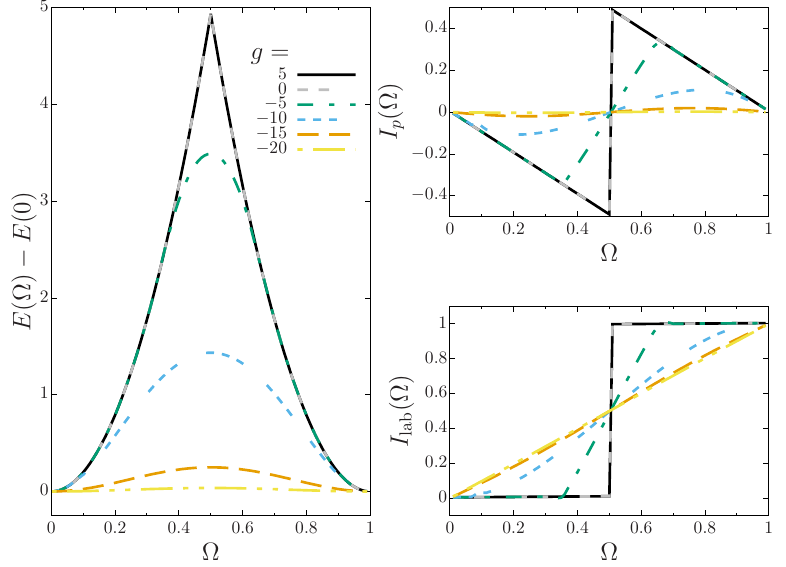
Figure 9: Mean-field simulations of the Gross-Pitaevskii equation, Eq. (27), for both attractive and repulsive interactions. The left panel shows the energy landscape as a function of the flux Ω , while the right panels show the current and current in the lab frame from top to bottom,